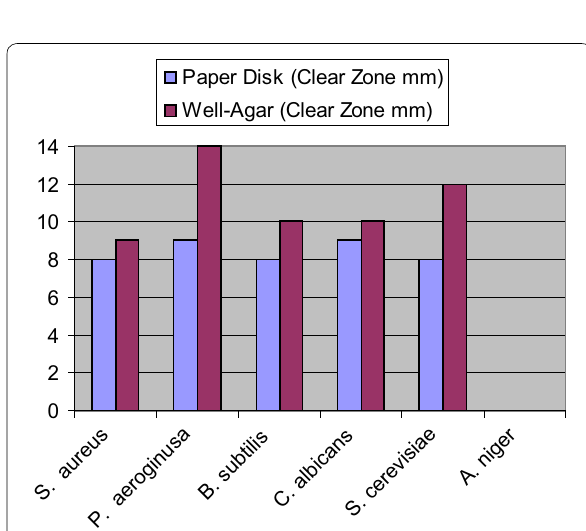
Fig. 2 Antimicrobial activity of compound 5b using agar disk diffu‑ sion method